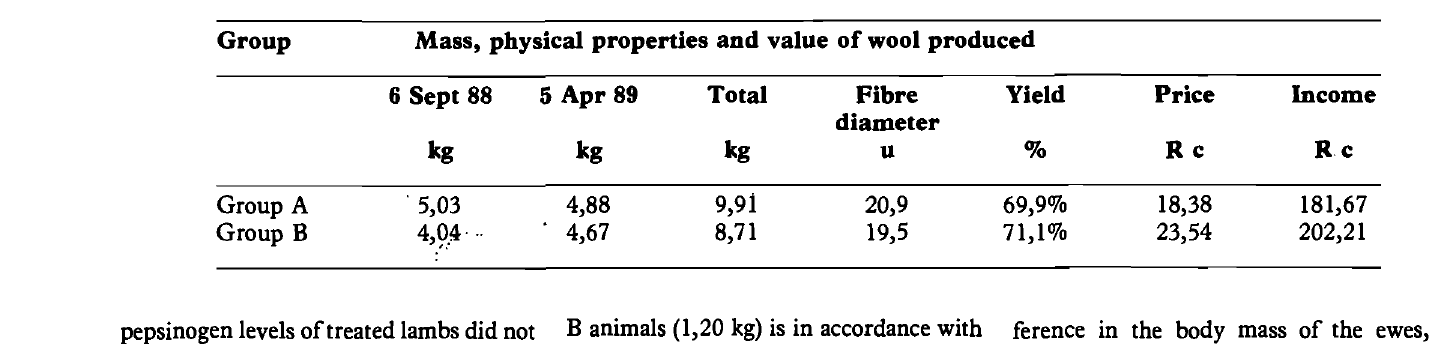
Table 3: The totat gross retum &om wool produced by each sheep Group